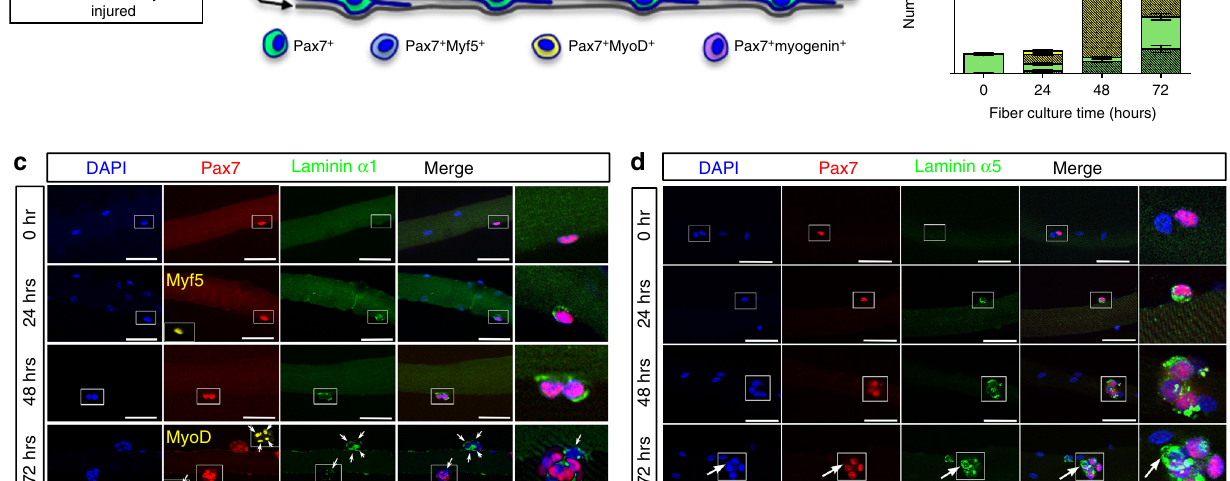
or little expression was observed in freshly isolated muscle fi bers remodel locally the BL associated with SCs. Matrix metallopro- (Fig. 2c). teinases (MMPs) substrates include ECM components, and thus are good candidates to mediate BL remodeling during muscle regeneration 24,25 . We focused on the gelatinases MMP2 and Matrix metalloproteinases trigger remodeling of the SC niche . MMP9, because gain and loss-of-function studies already sug- gested a link with skeletal muscle and the pathology of mdx Laminin- α 1 and laminin- α 5 incorporation into the satellite cell mice 26 – 28 . Although no MMP2 or MMP9 expression was BL soon after SC activation suggests an active mechanism to | DOI: 10.1038/s41467-018-03425-3 |